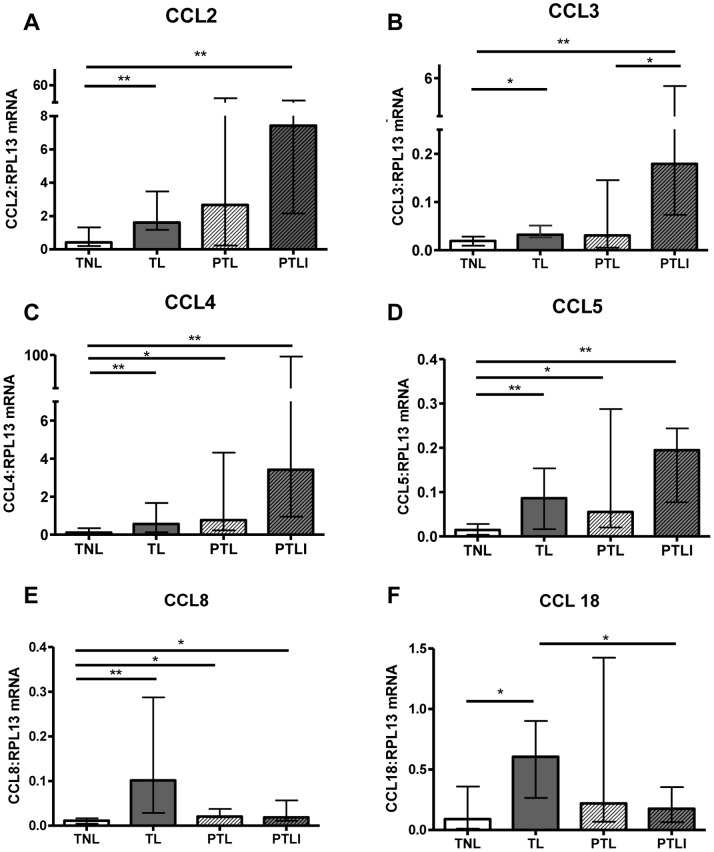
Choriodecidual CC chemokine mRNA expression in the four study groups.Chemokine mRNA expression was normalised to RPL13 mRNA expression levels. (A) CCL2, (B) CCL3, (C) CCL4, (D) CCL5, (E) CCL8, (F) CCL18. Individual replicates and the median are shown, n = 10–14/study group. TNL = Term not in labour, TL = Term labour, PTL = Preterm labour and PTLI = Preterm labour with infection. Data are median and interquartile range, *p<0.05 **p<0.01 (Kruskall-Wallis with Dunn’s post hoc test).